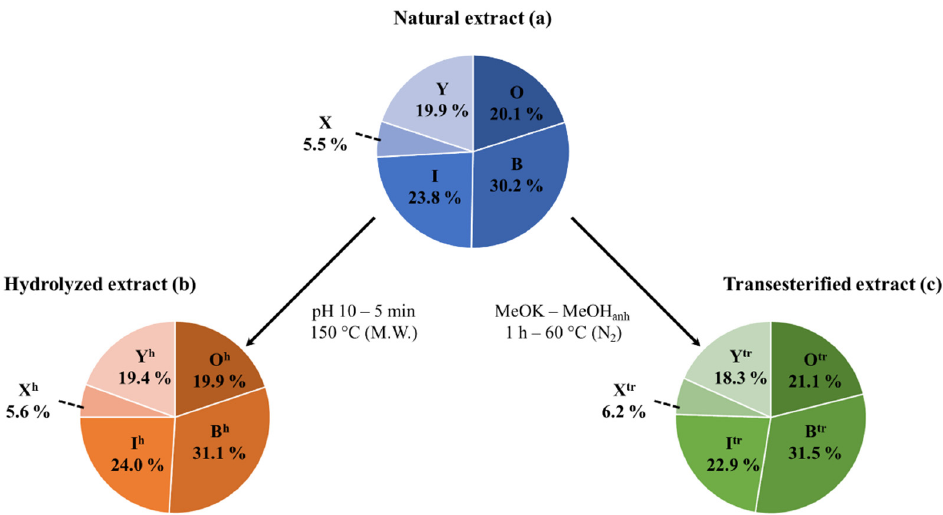
Figure 4. Mass spectrometry qualitative and quantitative analysis of the ( a ) natural, ( b ) hydrolyzed, and ( c ) transesterified saponin extracts: the saponin relative proportions (%) correspond to the molar proportions as determined by LC-MS signal integration. Please note that the relative proportions of Saponins X and Saponins Y correspond to the sum of the proportions of saponins G, 32 and 61 and the proportions of saponins N, 4, Q, H, 19 and F, respectively. M.W. stands for microwave activation.